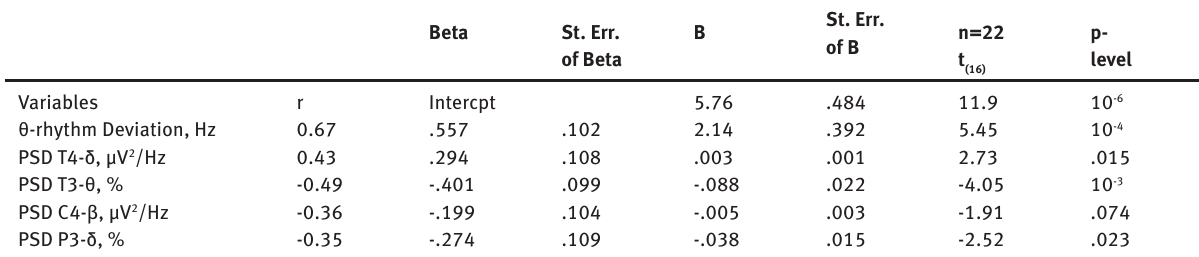
Table 2: Regression Summary for Dependent Variable: Segmentonucleary Neutrophiles